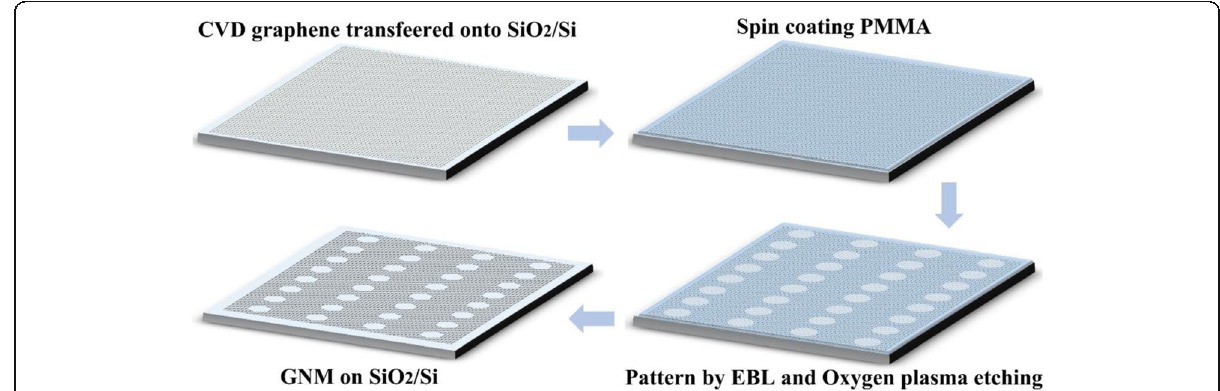
Fig. 1 Illustration of the fabrication process of a GNM by